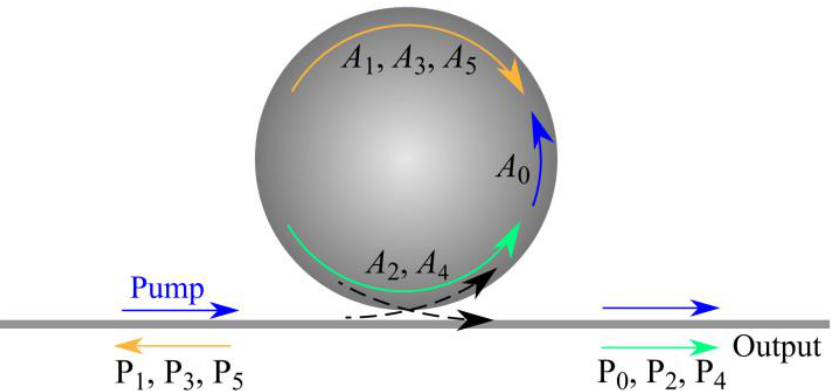
Figure 4. Schematic diagram of cascade Brillouin lasing in microsphere. Even-order Brillouin waves propagate in forward direction and odd-order Brillouin waves propagate in backward direction relative to pump wave. A j is intracavity field amplitude, P j is output power, subscript j indicates the jth order of the Brillouin cascade, j = 0 corresponds to pump wave. Only Brillouin orders considered in this study are indicated.